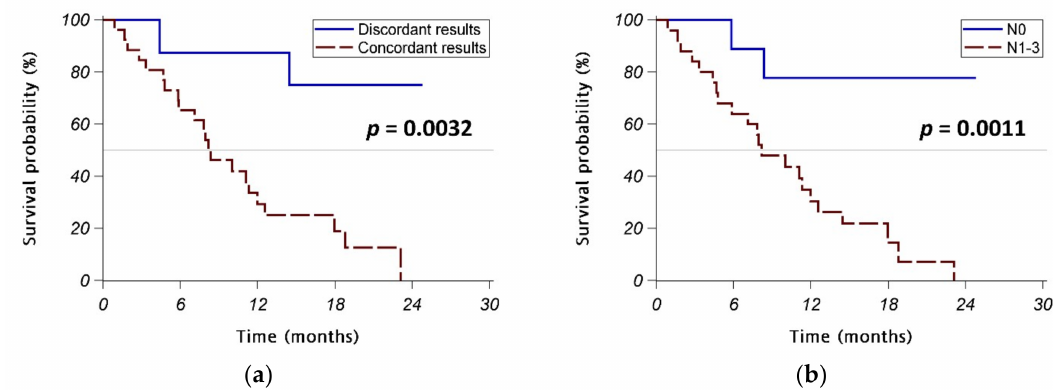
Figure A1. Progression-free survival (PFS) in stage IV patients receiving first-line EGFR TKIs (only patients using Qiagen ® EGFR RGQ PCR kit for their tissue samples). ( a ) Patients with concordant EGFR mutation test results in liquid / tissue biopsy vs. those with discordant results. ( b ) Patients with lymph node involvement (N1–3 disease) vs. those without lymph node involvement (N0 disease). Abbreviations: EGFR = epidermal growth factor receptor; ECOG = Eastern Cooperative Oncology Group; TKI = tyrosine kinase